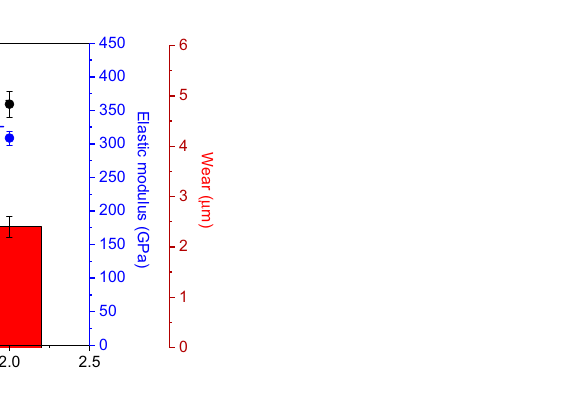
Figure 11. Residual stress evolution in the CrN/Cr 1-x Al x N multilayers deposited onto gas nitrided diesel piston rings as a function of the applied carousel rotational speed.